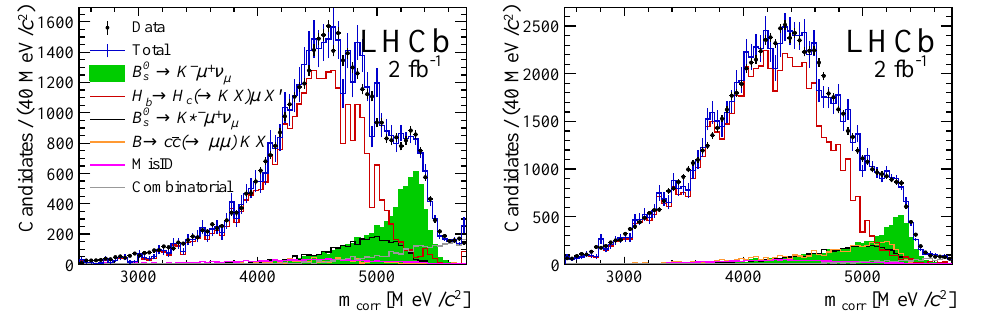
→ K − µ + ν 2 < 7GeV 2 / c 4 µ with (low) q s